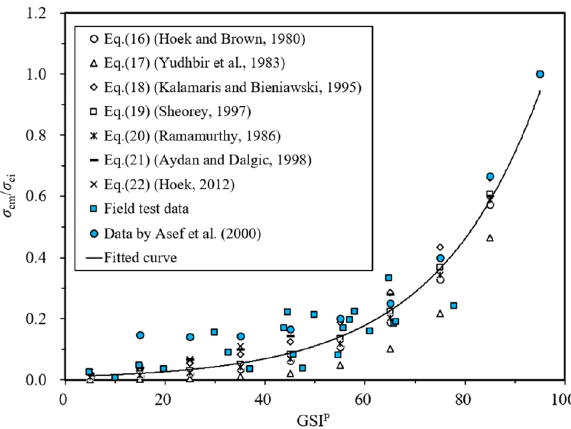
Figure 3. Fitting for σ ci / σ cm